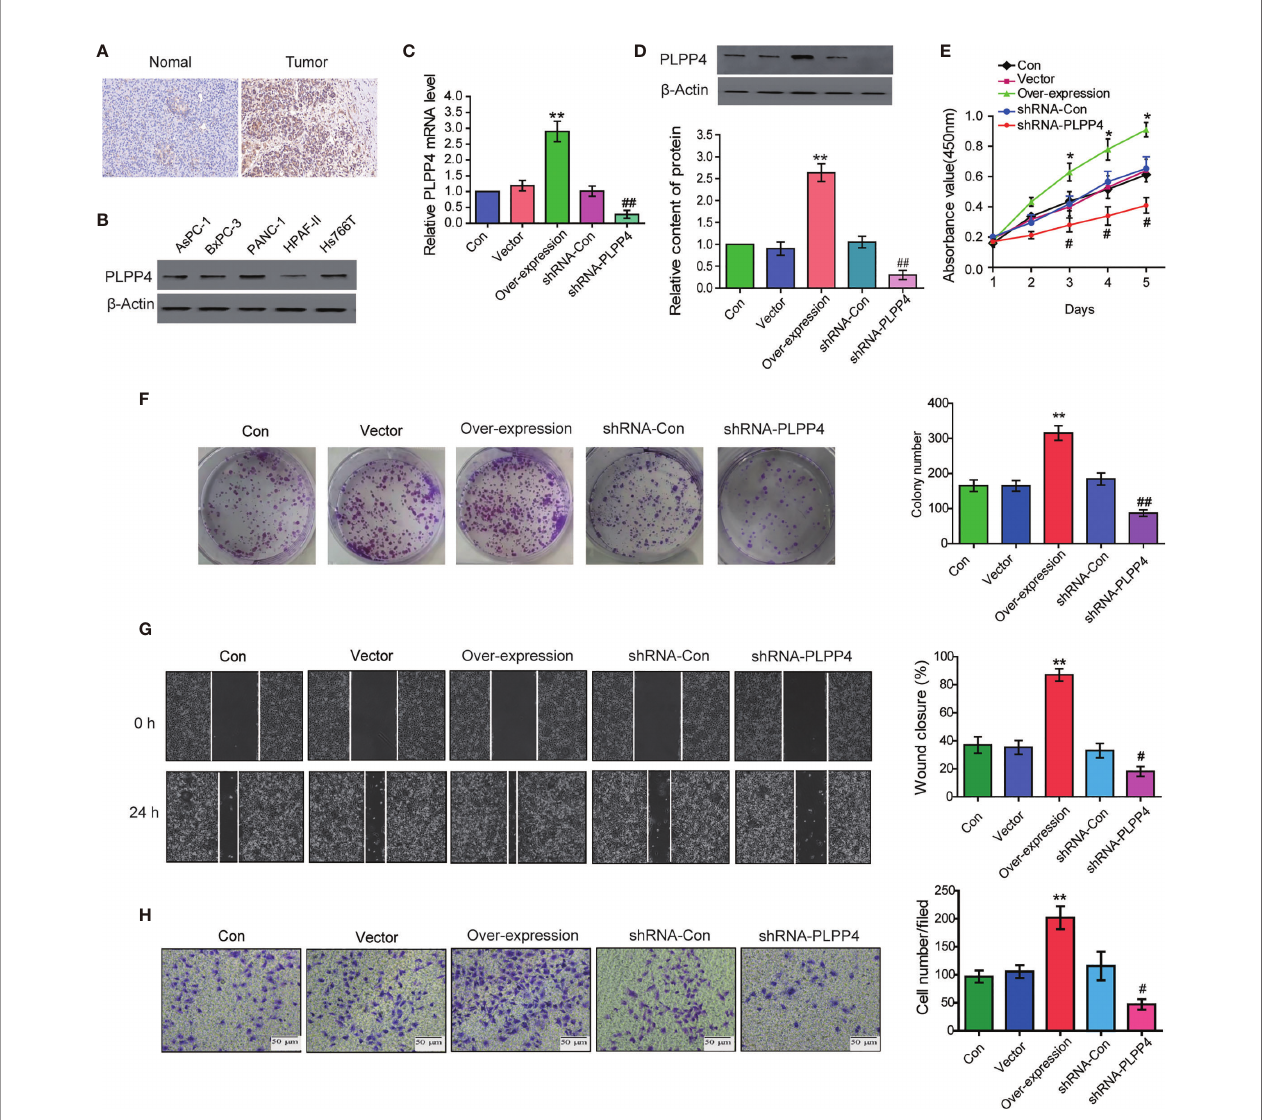
FIGURE 11 | Silencing PLPP4 decreased the proliferation, migration, and invasion of pancreatic cancer cells. (A) Expression of PLPP4 protein in pancreatic cancer, a representative image of immunohistochemical analysis of paraf fi n-embedded specimens from 65 cases of primary pancreatic cancer. (B) Western blot was used to detect the expression of PLPP4 protein in different pancreatic cancer cell lines. (C) The real-time PCR assay was used to detect the expression of PLPP4(vector, over-expression, shRNA-con, shRNA-PLPP4) in PANC-1 cells. (D) Western blot analysis of PLPP4 expression in PANC-1 cells of pancreatic cancer. (E) PANC-1 cells proliferation was analyzed with the CCK-8 assay at 1, 2, 3, 4, 5 days. (F) Silencing PLPP4 reduced the mean colony number in PANC-1 cells according to the colony formation assay. (G) shRNA-PLPP4 or over-expression PLPP4 was transfected into PANC-1 cells, and the migration of cells in each group was detected by the scratch method. (H) Invasion assay was used to detect the invasion of PANC-1 cells. Each bar represents the mean values ± SEM of three independent experiments. Compared to vector, * P < 0.05, ** P < 0.01; compared to shRNA-Con, # P < 0.05, ## P <